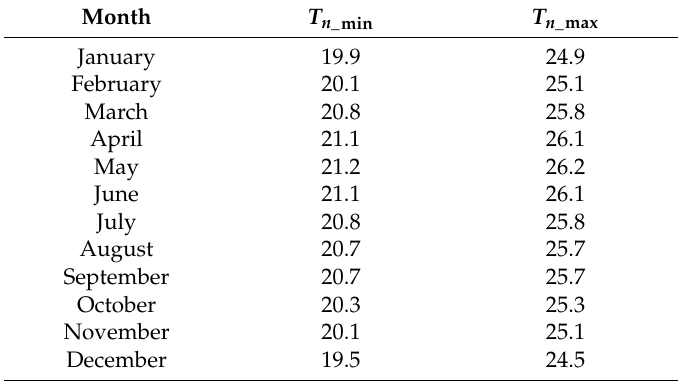
Table 2. Monthly thermal comfort range upper and lower limits in ◦ C for Mexico